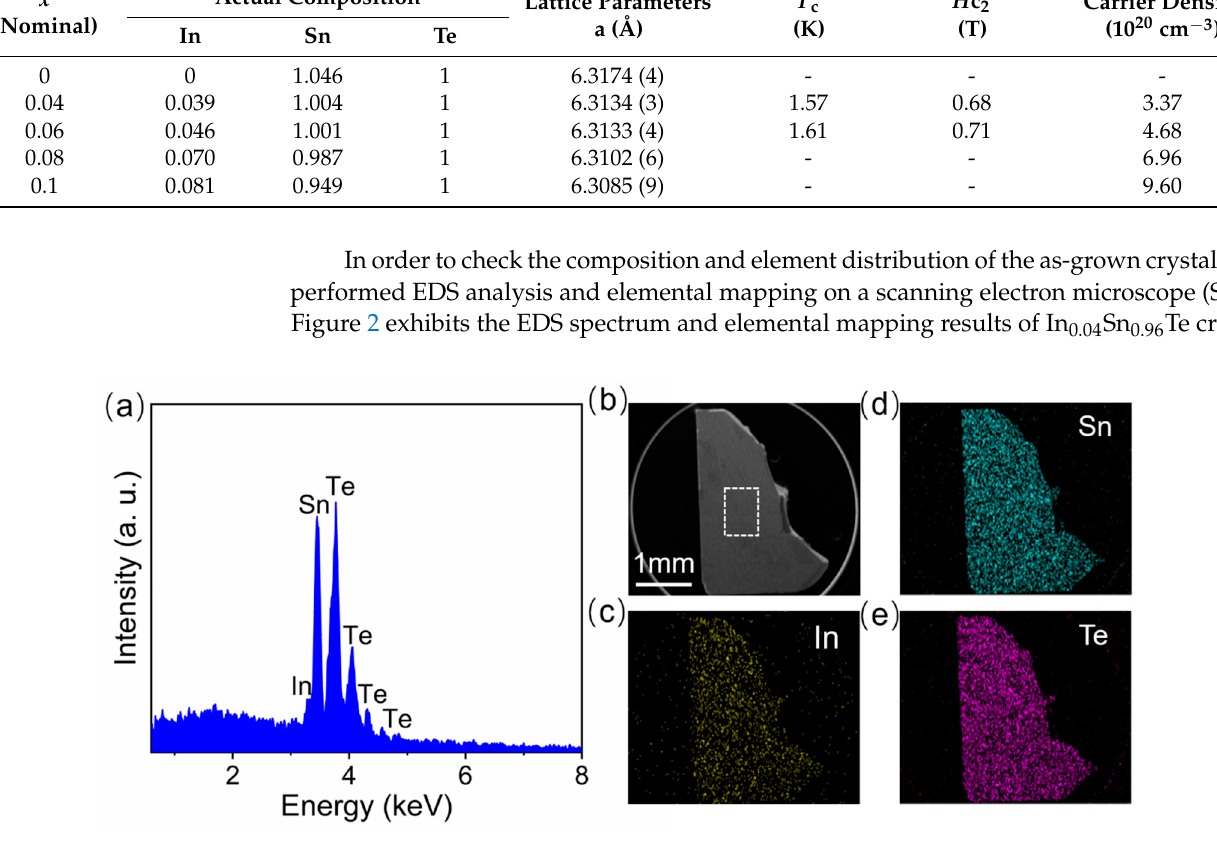
Figure 2. ( a ) Energy-dispersive X-ray (EDS) spectrum results of In 0.04 Sn 0.96 Te single crystal, confirming the existence of element In, Sn and Te. ( b ) Scanning electron microscope (SEM) image of In 0.04 Sn 0.96 Te single crystal. ( c – e ) EDS element mapping of In 0.04 Sn 0.96 Te single crystal, showing distribution of In, Sn and Te.